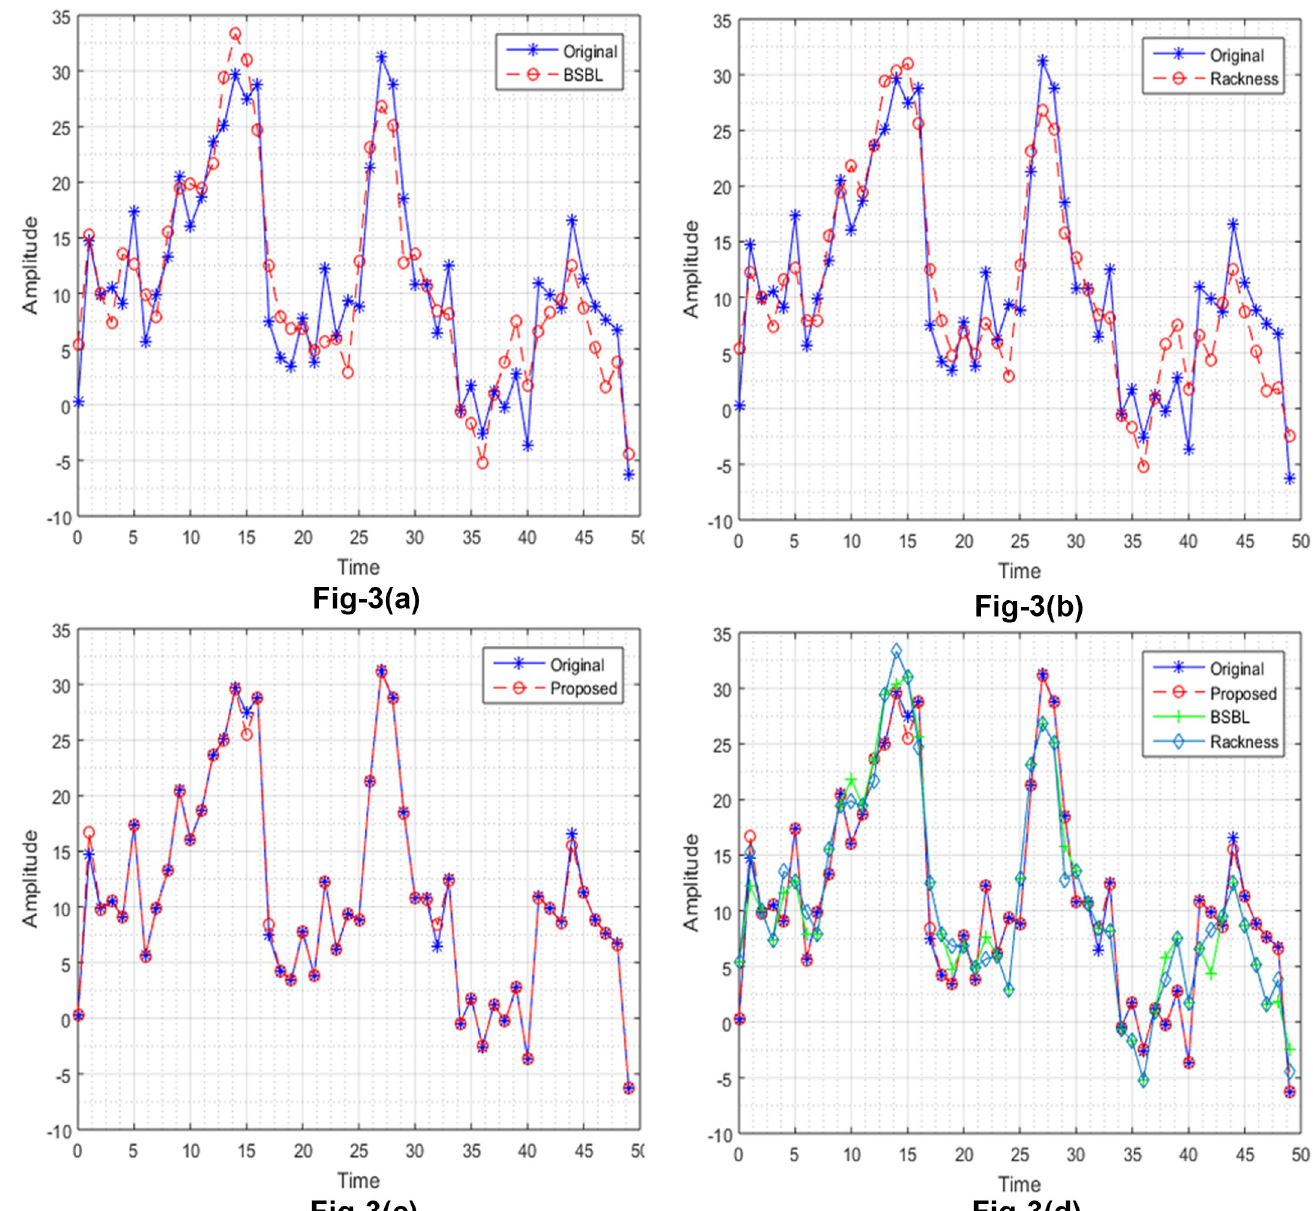
Fig 3. Reconstruction. Overlayed original and reconstructed EEG signal for duration 0-50secs A: BSBL. B: Rackness. C:Proposed D:Combined.